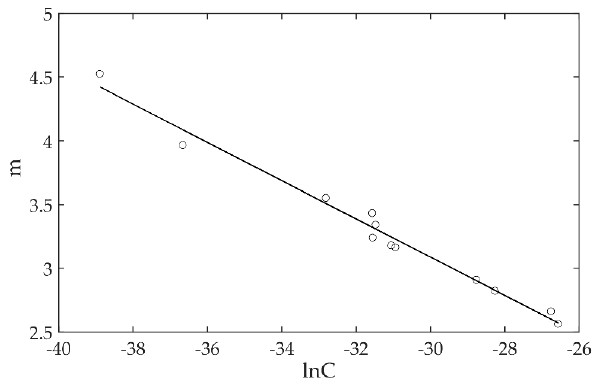
Figure 8. The linear regression statistical analysis of material parameters.